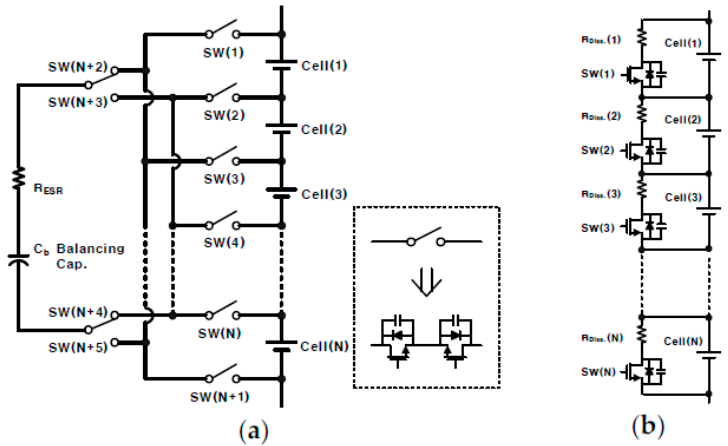
Figure 5. Schematic of the cell-balancing circuits: ( a ) the ACB circuit; ( b ) the PCB circuit.